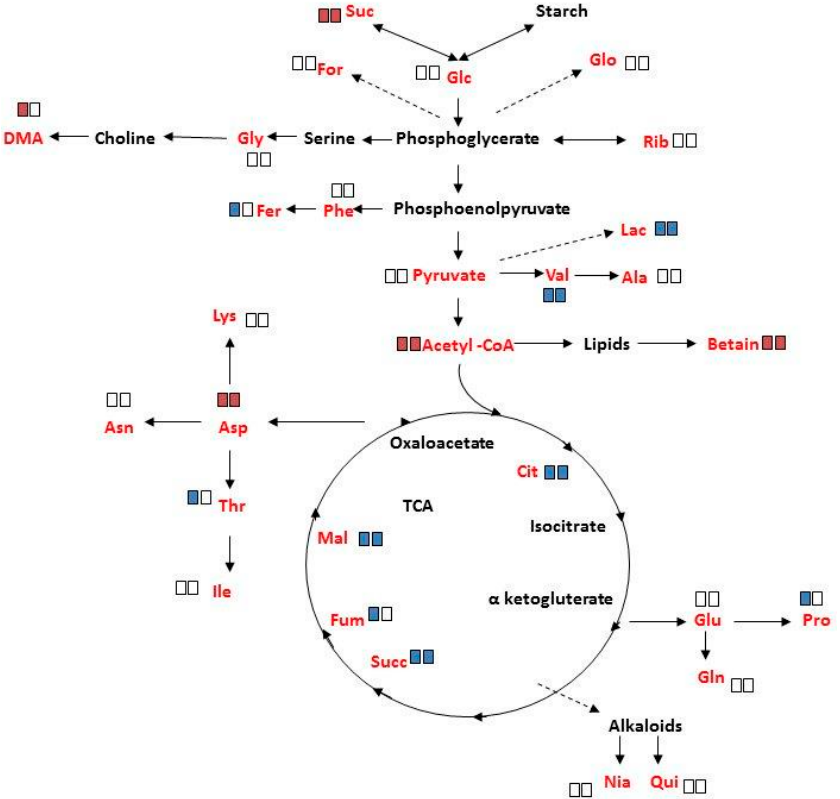
Figure 6. Schematic metabolic pathways showing changes in leaf metabolites concentration of ‘Young stage’ M. annua under salinity. Plant of M. annua at ‘young stage’ (55 days) were exposed to NaCl (100 mM) for 3 days. Extraction of polar metabolites from female and male leaf and root was done with perchloric acid. Left rectangle—female; right rectangle—male; red rectangle—increase; blue rectangle—decrease; Empty rectangle indicates no significant change under salinity. Significant changes at p < 0.05 are shown. Metabolites written in red were identified by 1 H NMR. Metabolites written in black were below detection threshold.